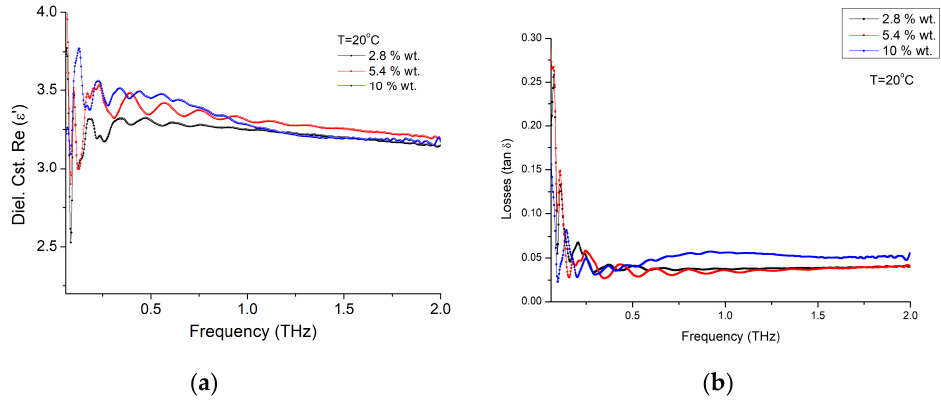
Figure 9. BTO-epoxy film composite ( a ) dielectric constant ε′ and ( b ) losses variation with frequency at room temperature, for different nanoparticle concentrations of 2.8 wt.%, 5.4 wt.% and 10 wt.%.